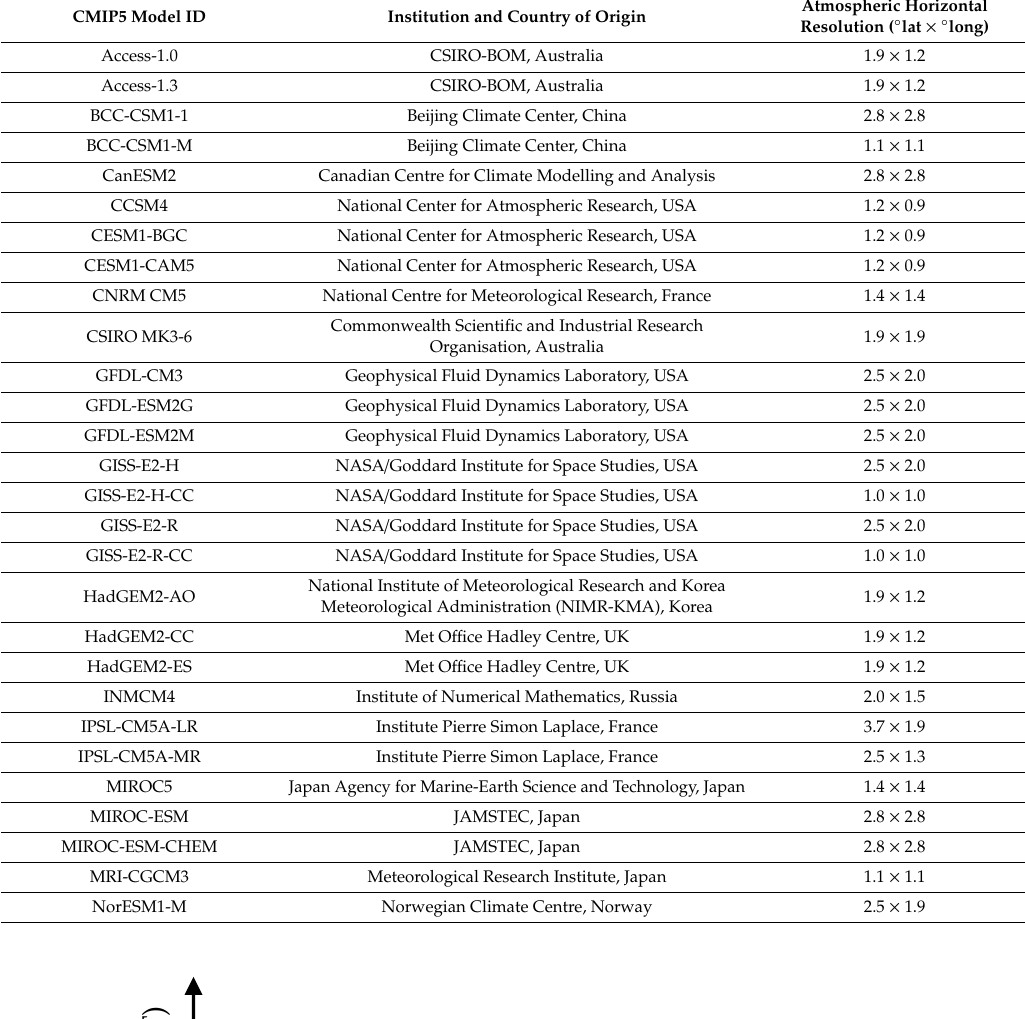
Table 2. List of global climate models their founding institution and spatial resolution.